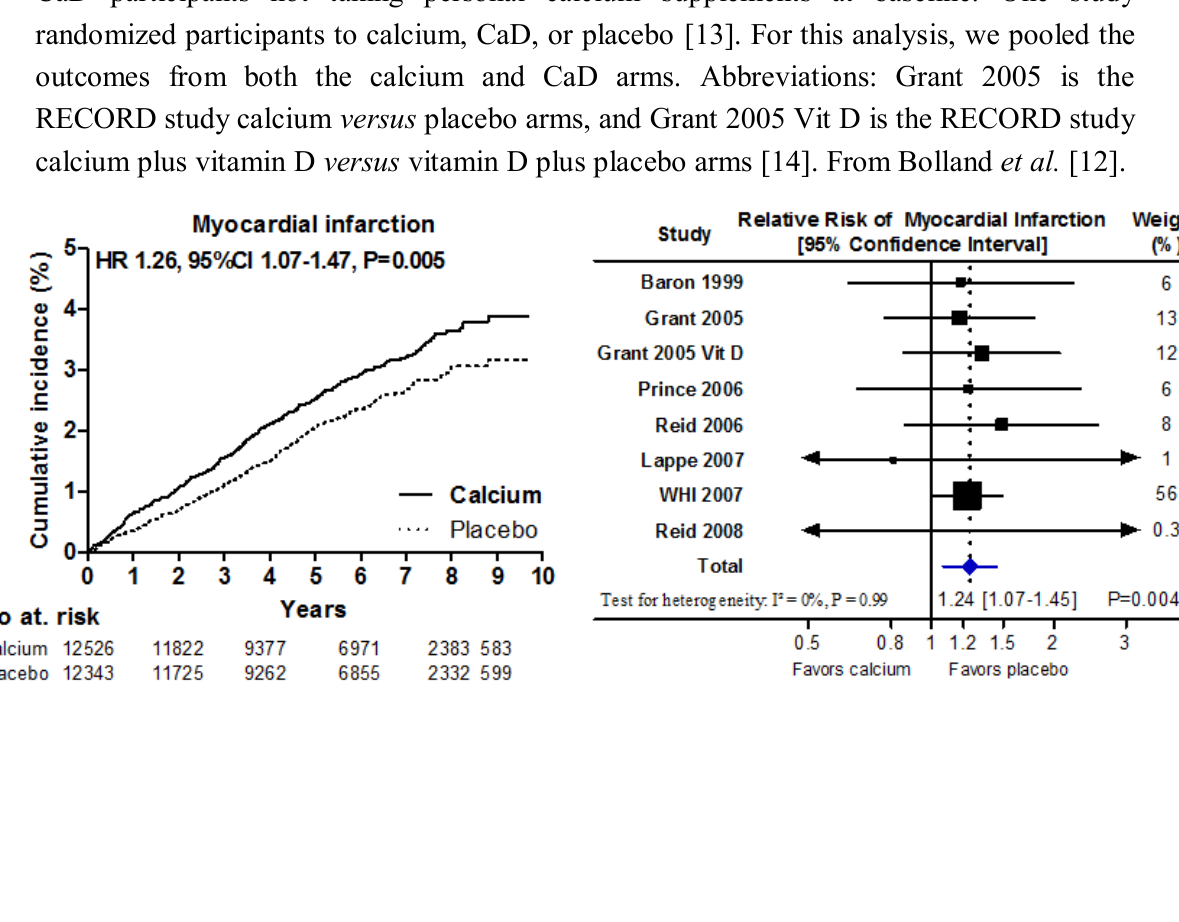
Figure 1. Patient-level meta-analyses of the effect of calcium supplements with or without vitamin D on cardiovascular events (left-hand panels) and corresponding